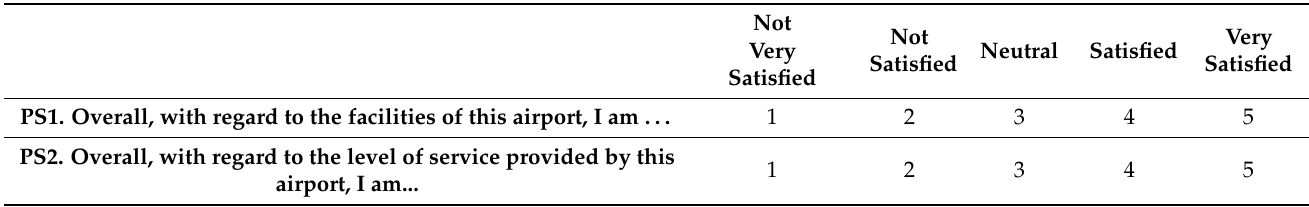
Table A4. Passenger Satisfaction.